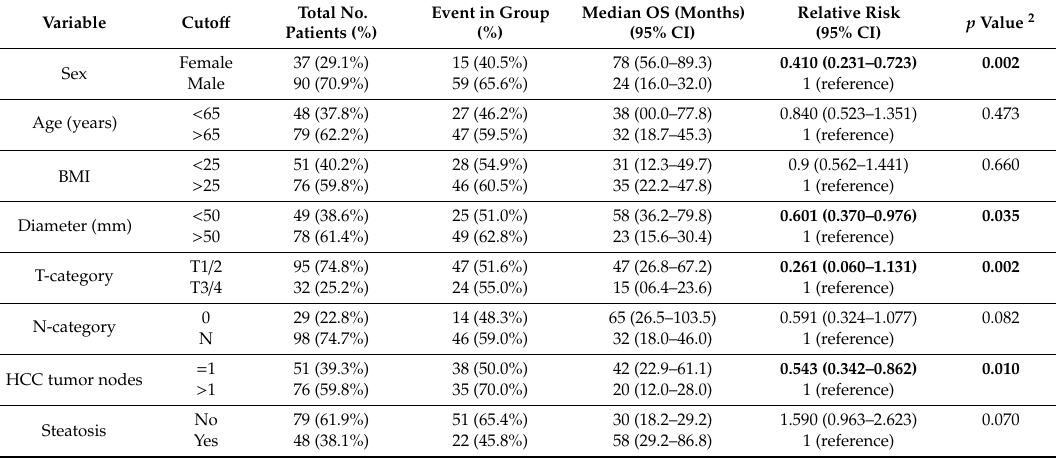
Table 3. Demographic and clinico-pathological characteristics and overall